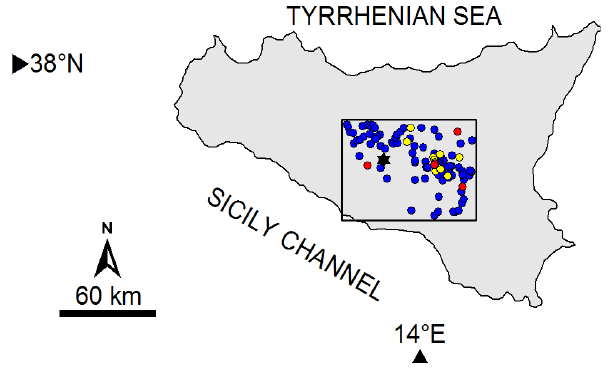
Fig. 11. Epicentral location of all the seismic events recorded in Central Sicily during the 2002–2009 period. Red circles are the August 2008 events, yellow circles are the August 2009 events, and blue circles all the others. The black star is the Santa Barbara area.